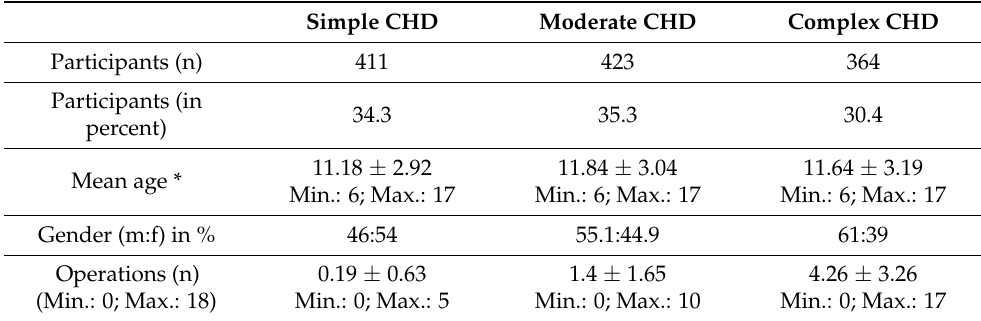
Table 1 modified according to Jahn, Annika (2022): Körperliche Aktivität und Sportver- halten bei Kindern und Jugendlichen mit angeborenen Herzfehlern—eine deutschlandweite Analyse. Universität Ulm. Dissertation. http://dx.doi.org/10.18725/OPARU-46553 (accessed on 13 October 2022). Table 2. CHD classification according to Warnes et al. [24]. Simple CHD Moderate CHD Complex CHD